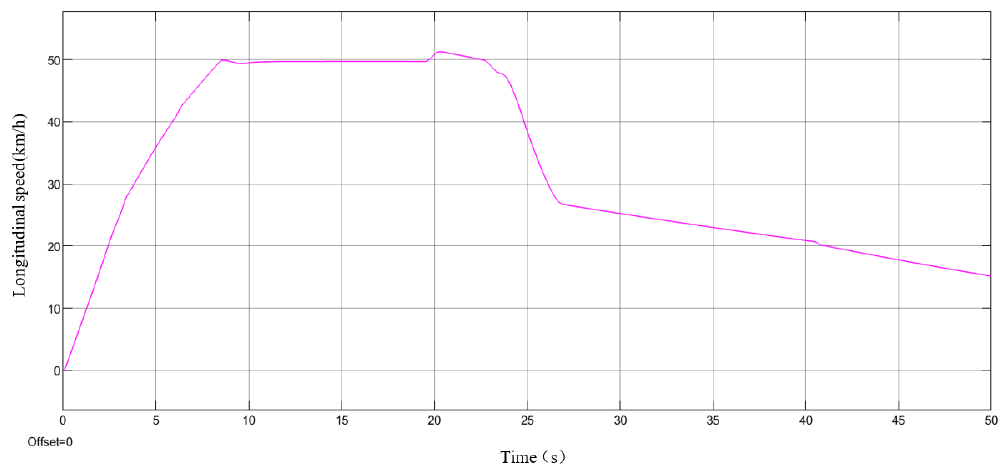
Figure 6. Longitudinal speed variation curve for fishhook test.